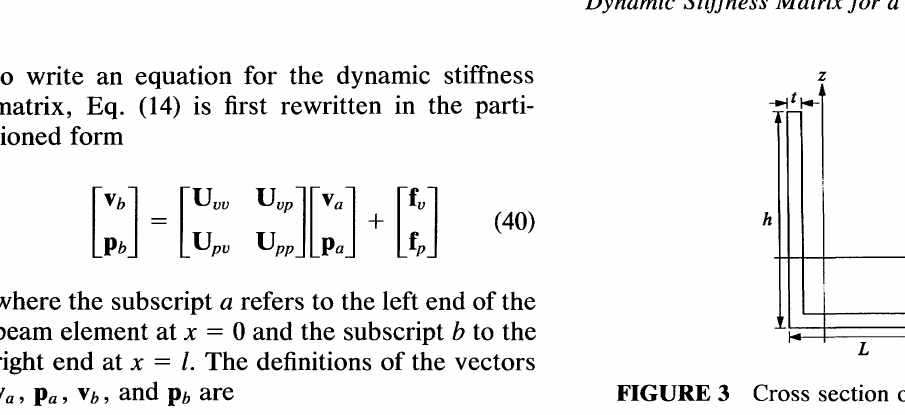
FIGURE 3 Cross section of the example beam.